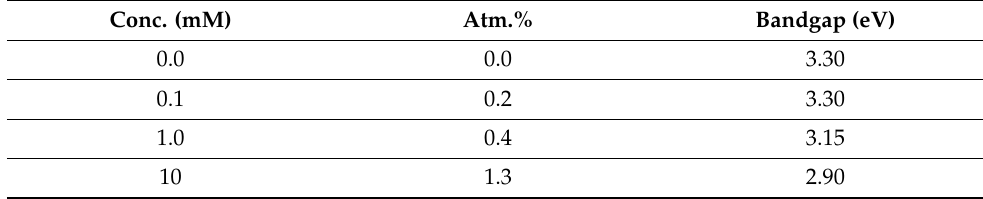
Table 2. Concentration dependence on atomic concentration of Cu and bandgaps.